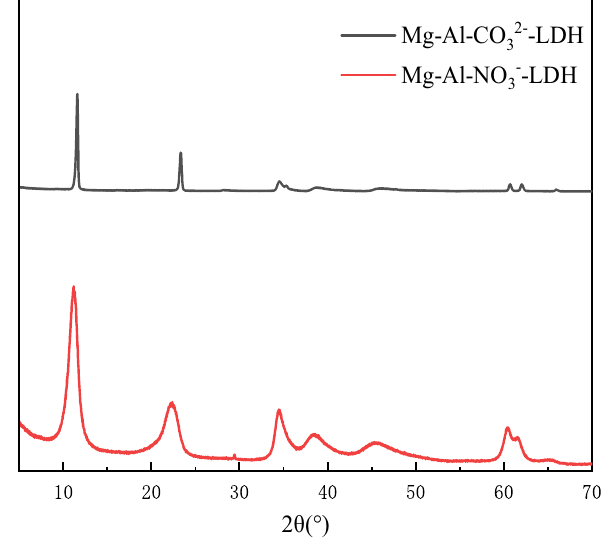
Figure 1: XRD result of Mg – Al -